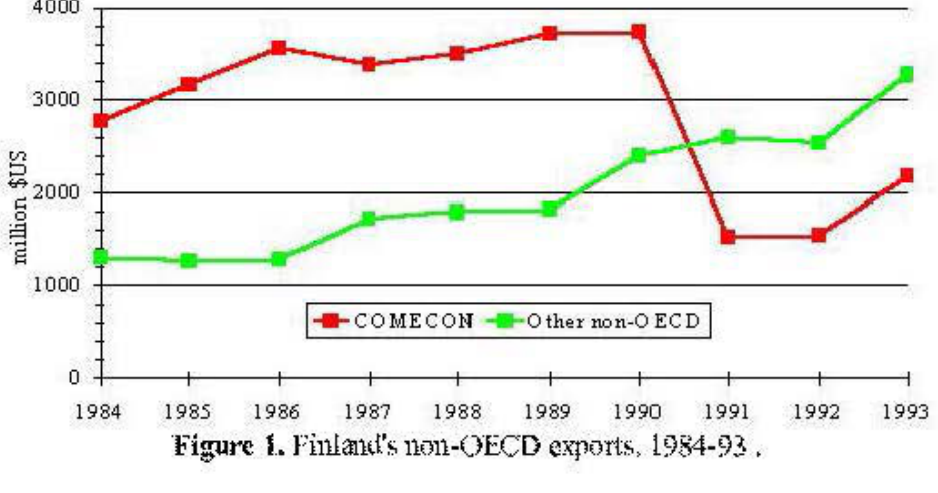
Figure I .• Fi1tlaml's 11011-0ECD exports. 1984-93